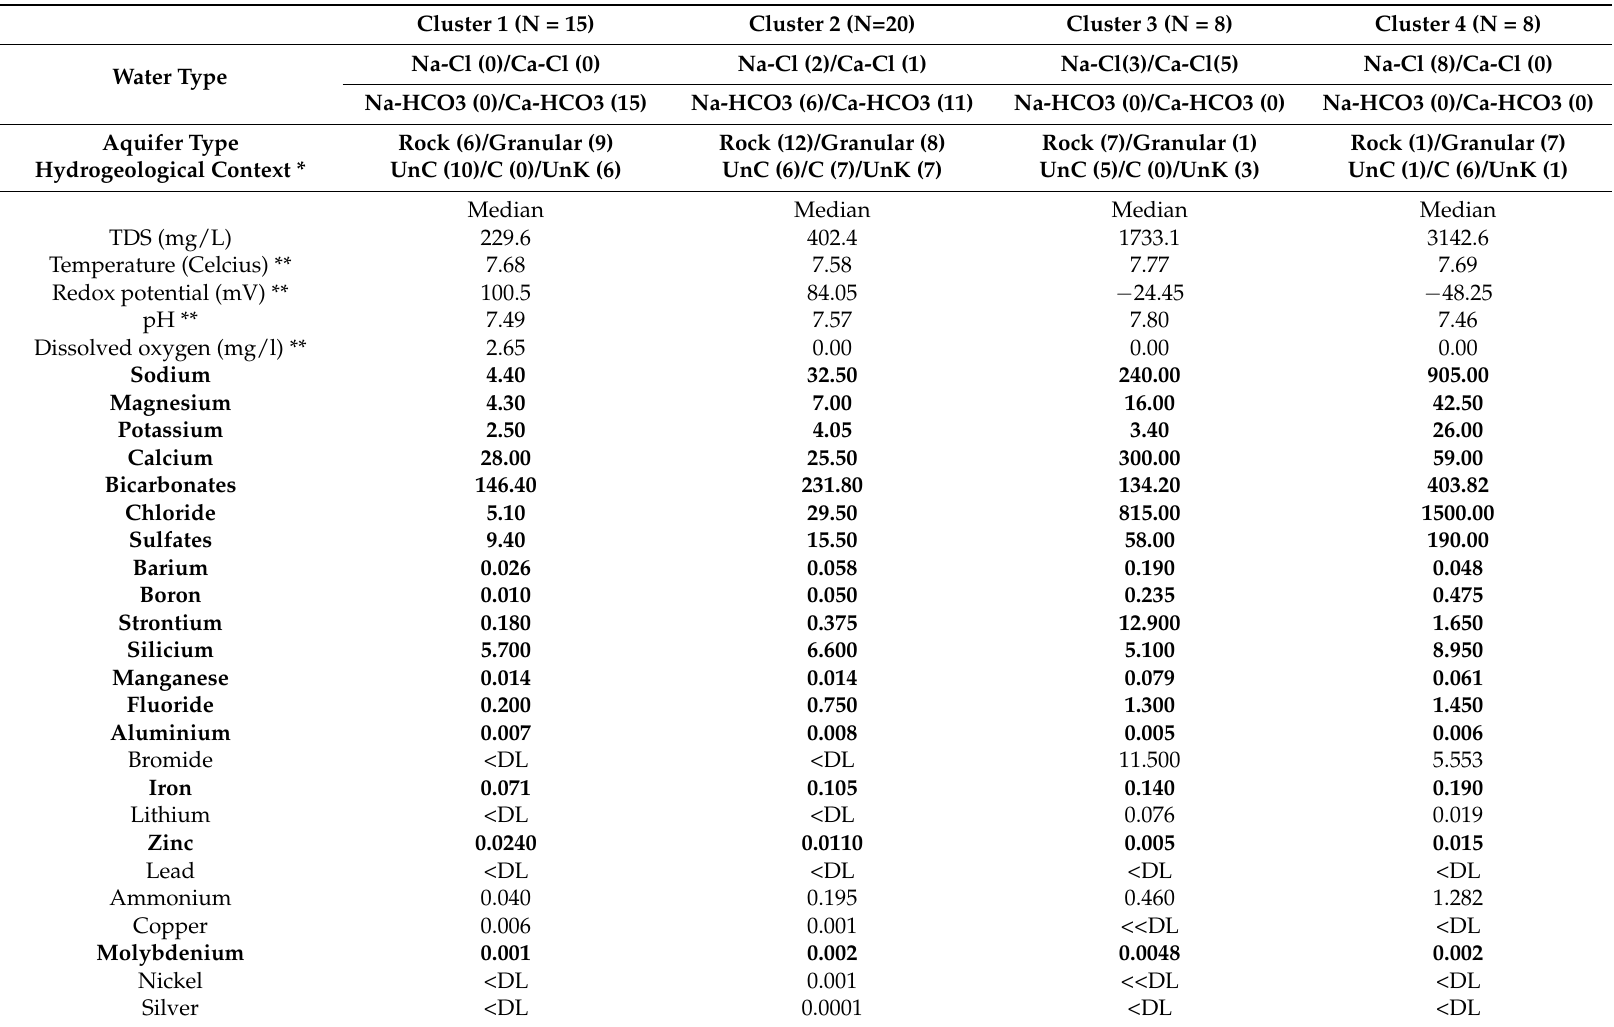
Table 5. Water type, aquifer type, and chemical content (median) of the 4 Clusters obtained by hierarchical Cluster